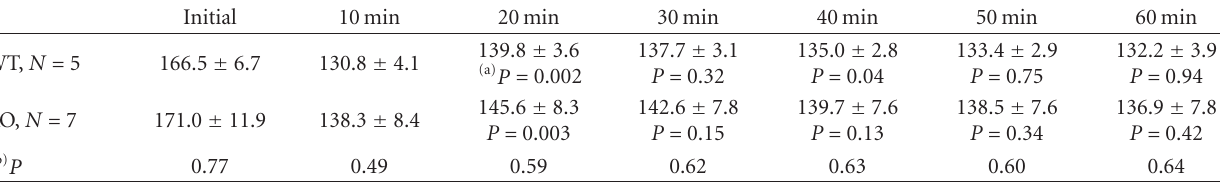
Table 2: Tetanic forces (kN/m 2 ) of WT and dysferlin-null soleus muscles at room temperature before and after saponin exposure. Initial 10 min 20min 30